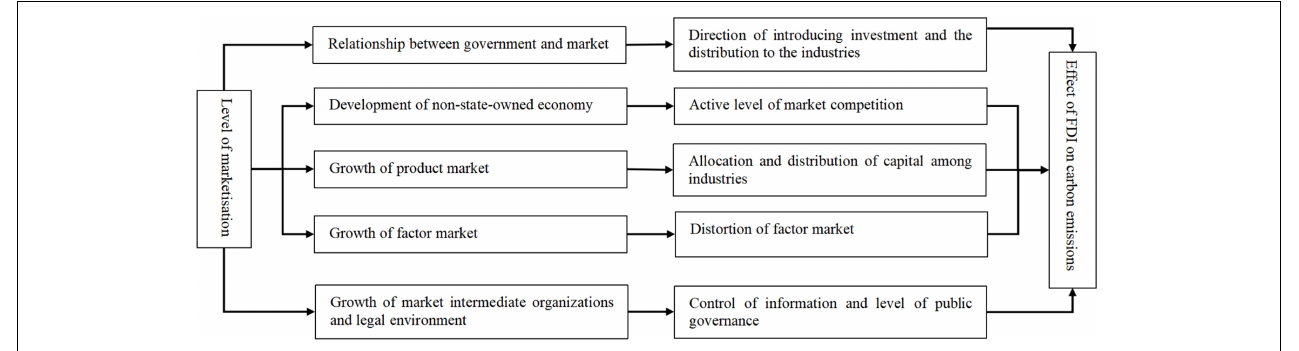
FIGURE 1 | Level of marketisation and its mechanism in the effect of FDI on carbon